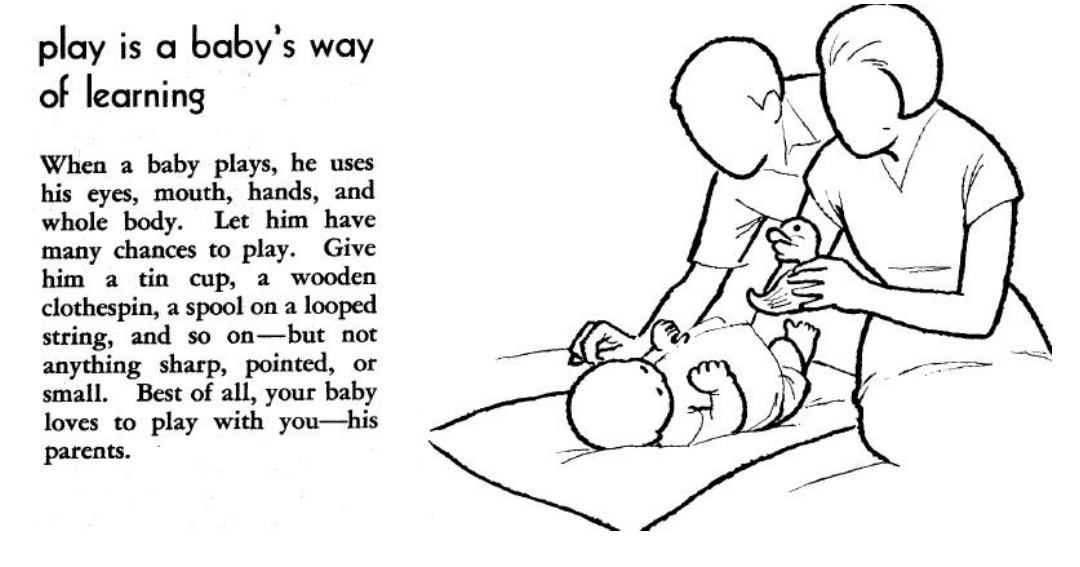
Figure 28. Play is Baby’s Way of Learning.